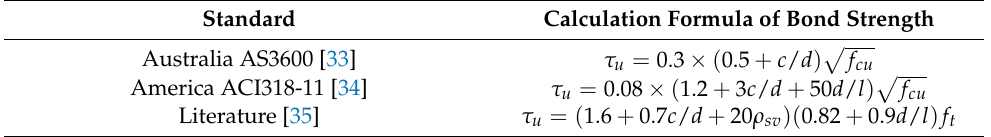
Table 6. Calculation formula of bond